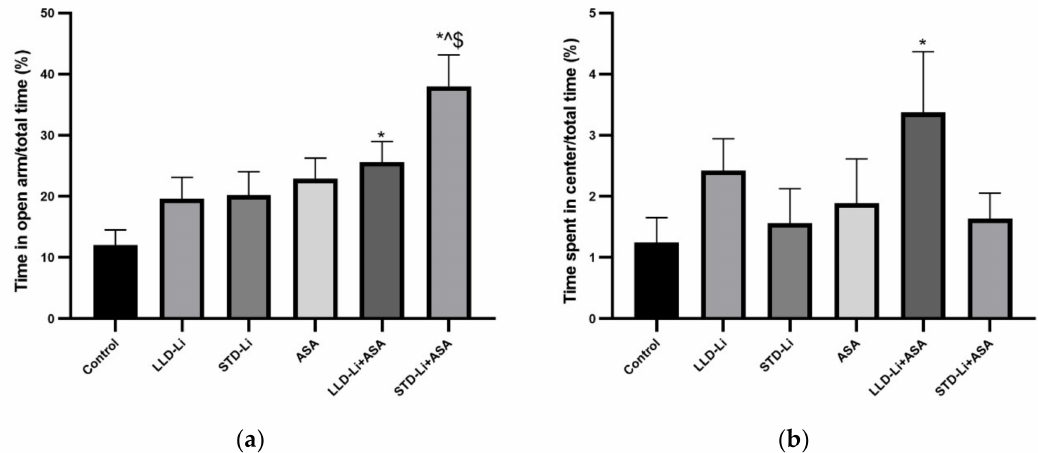
Figure 10. Anxiety-like behavioral facets in aspirin + Li-treated rats. Rats were fed regular food (control) or Li-containing food [LLD-Li or STD-Li] for 42 days. Low-dose ASA (1 mg/kg, ip) was administered alone or together with Li. ( a ) On treatment day 14, rats were subjected to an EPMT for five minutes. ( b ) On day 35, rats were placed in an open field arena for 20 min and their locomotor activity was monitored. In both tests, rats’ behavior was videotaped and subsequently analyzed by a video-tracking system as described in Materials and Methods. ( a ) Results are the means ± SEM of a single representative experiment out of two demonstrating a similar pattern with 9–12 rats per group in the depicted experiment. Two-way ANOVA: ASA effect, F 1,60 = 13.38, p = 0.0005; Li effect, F 2,60 = 406, p = 0.016; aspirin x Li interaction: F 2,60 =